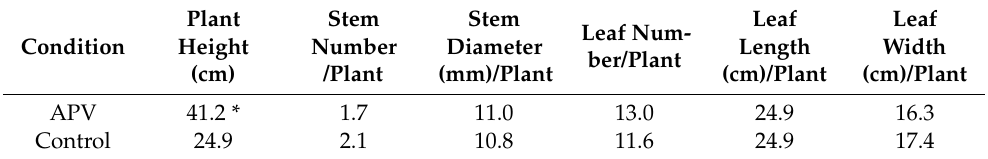
Table 2. Growth of potato underneath an agrophotovoltaic (APV) system in Chongju, South Ko- rea,